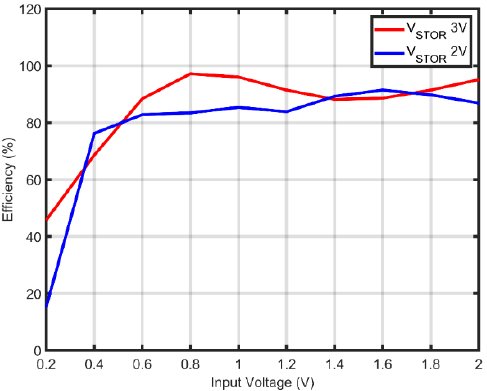
Figure 13. The measured boost converter efficiency curve ( I IN = 0.656 mA).